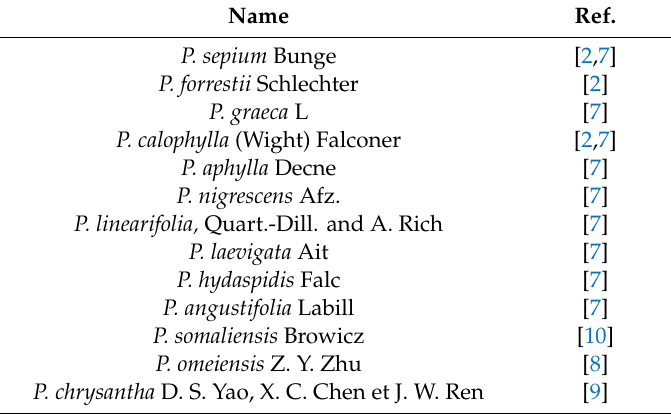
Table 1. Thirteen studied species of the genus Periploca .